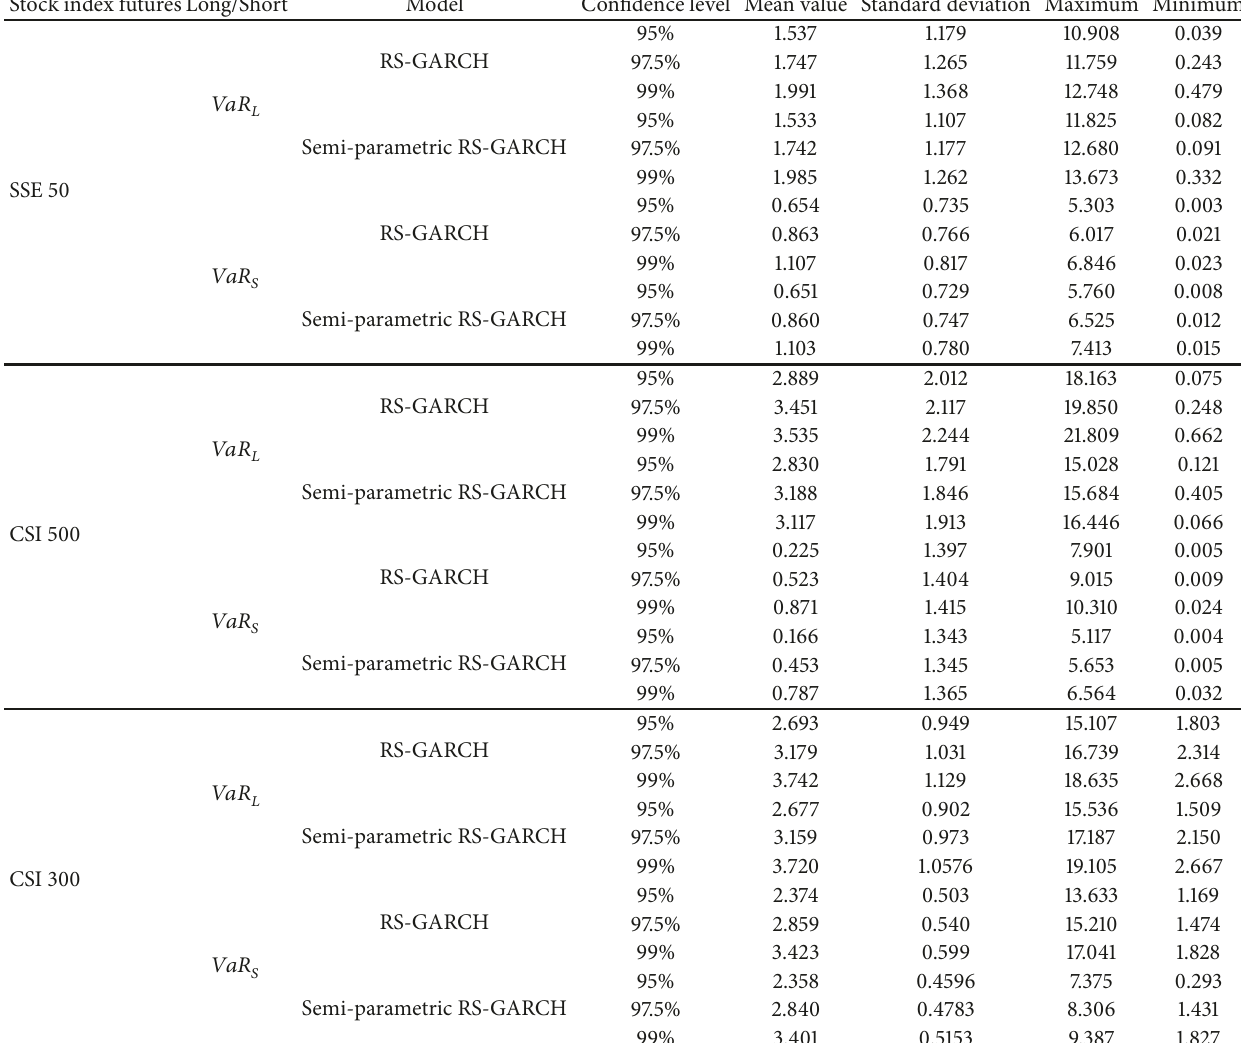
Table 9: The estimation results of VaR of the basis for stock index futures.